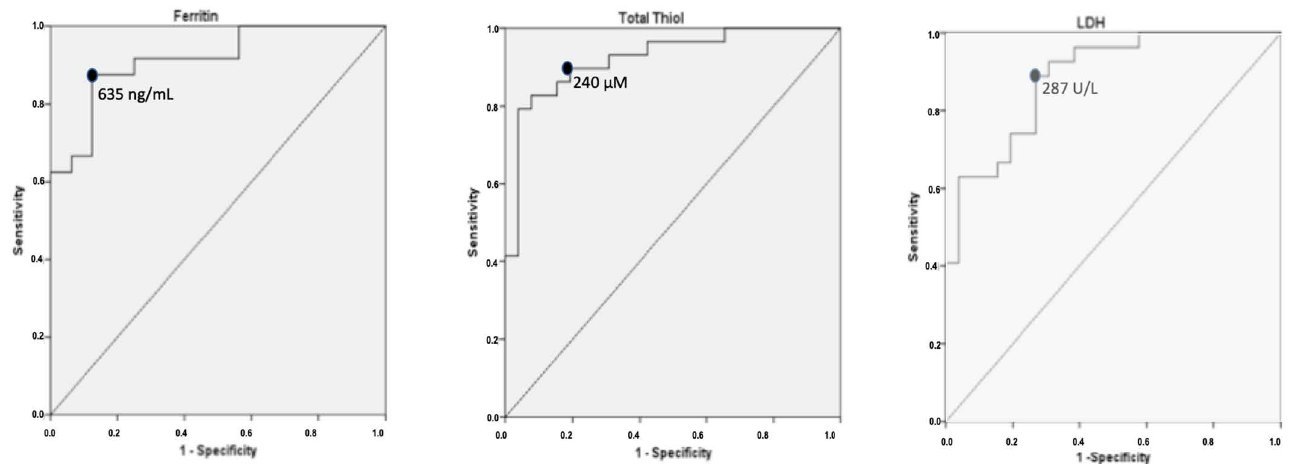
Figure 1. Areas under the curves and cut-off values of ferritin, total thiol and LDH in the distinction between patients who develop acute respiratory distress syndrome and patients with mild to moderate disease.